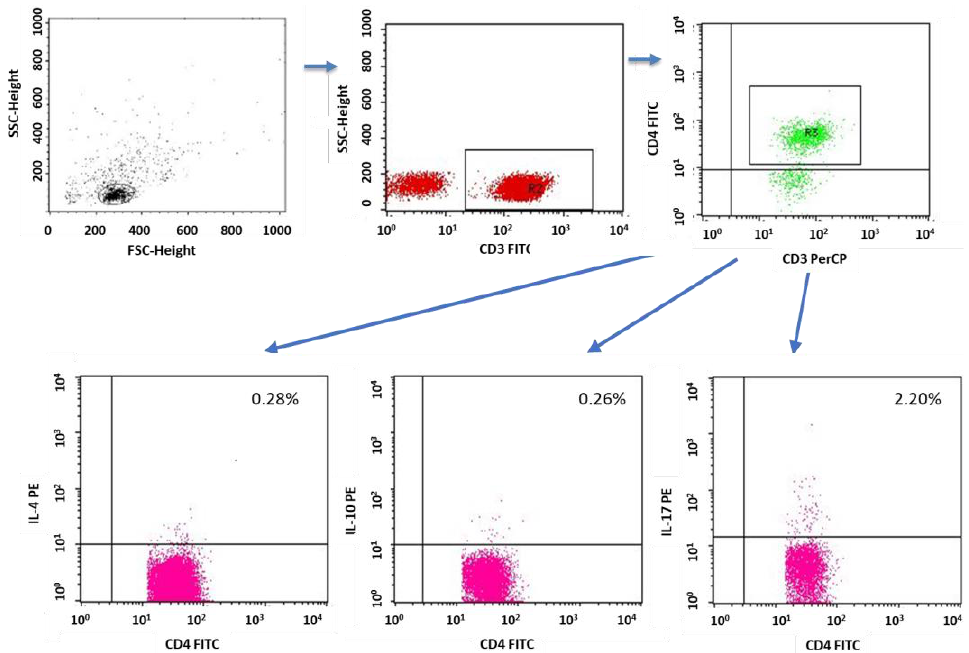
Figure 13. Sample analysis of the percentage of T cells with the CD4+CD3+IL-4+, CD8+CD3+IL-10+ and CD4+CD3+IL-17+ phenotypes.